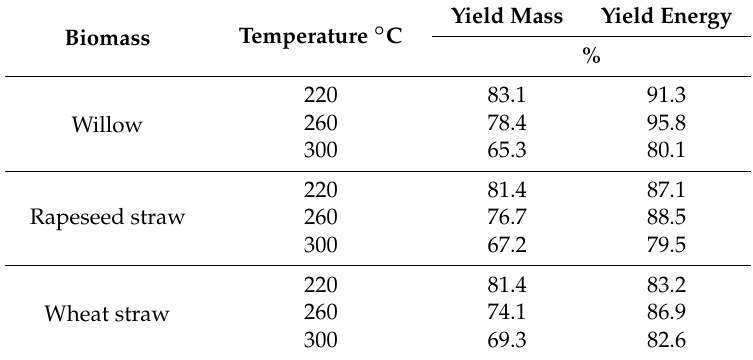
Table 2. Effect of torrefaction temperature in mass and energy